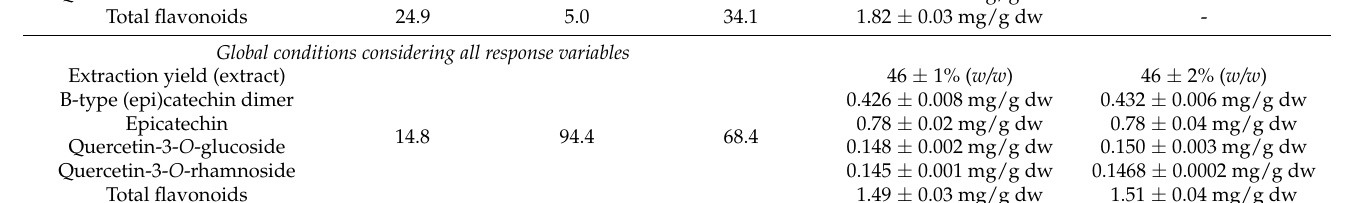
Figure 1. Response surface graphs for the combined effects of the independent variables on the content (mg/g) of individ- ual flavonoids ( Y 2 – Y 5 ) recovered from kiwi peel. In each graph, the excluded variable was fixed at its optimal value.